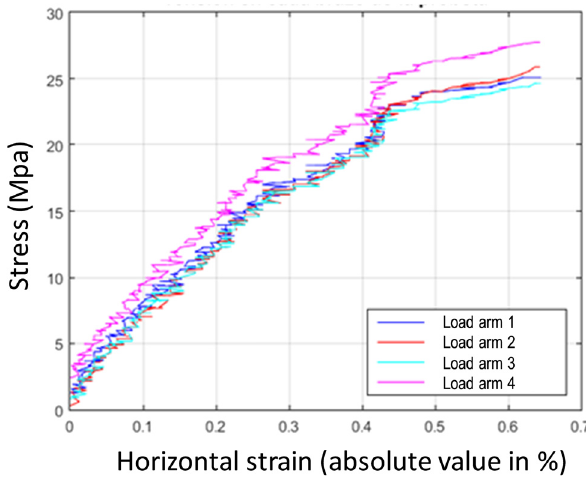
Figure 6: Example of the absolute values of the longitudinal normal stresses vs absolute value of the horizontal compression strain for a particular test.